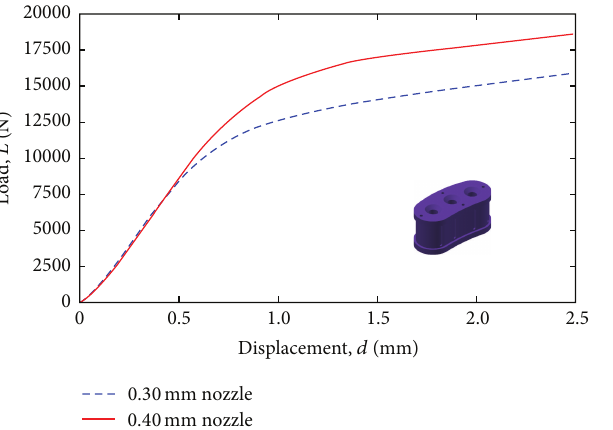
Figure 10: Compression testing for design concept (a), with differ- ent FDM nozzle configurations (0.30 versus 0.40 mm).